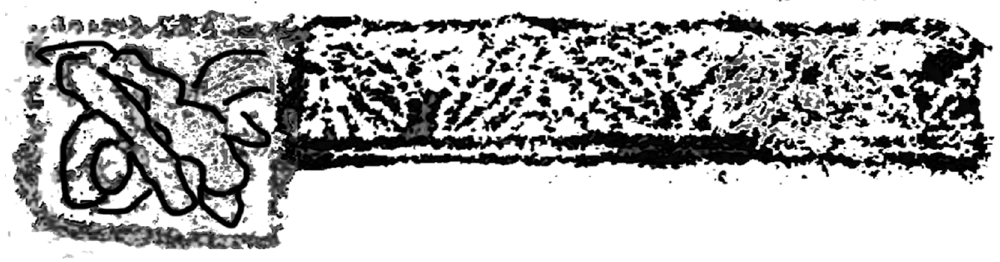
Figure 14. A tomb stone from Mongolian culture with a “Shoutao” lotus. The Yuan Dynasty. Sketched by author. Picture source: Tjalling and Wei (2005), p. 169.